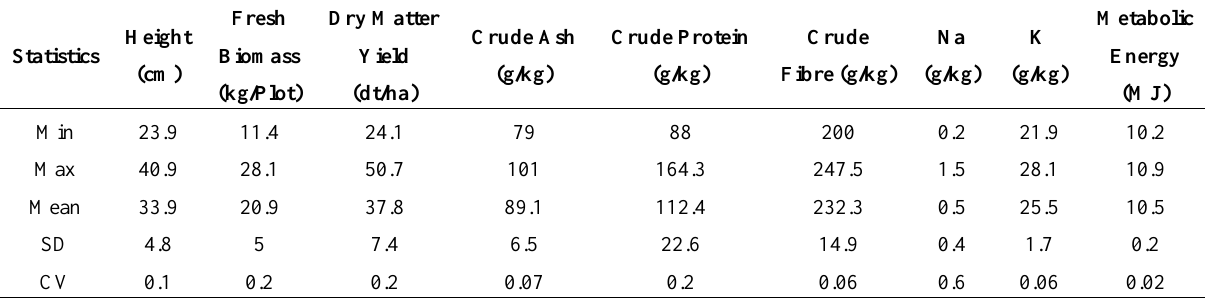
Table 3. Summary statistics of the selected grassland parameters for the May harvest. (SD: Standard Deviation; CV: Coefficient of